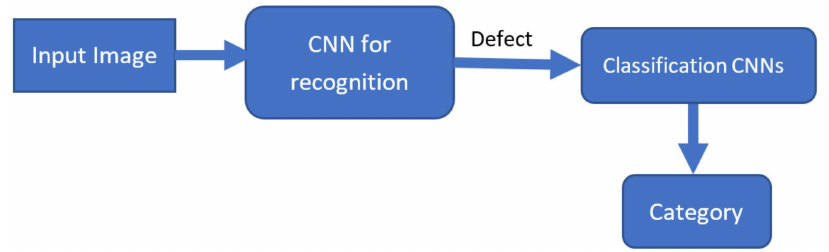
Figure 3. Block diagram of the two-step process for defect recognition and